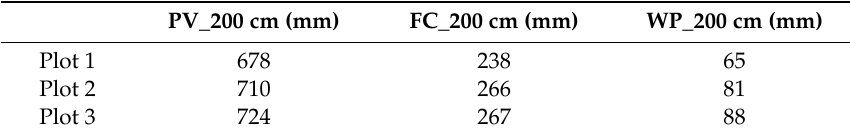
Table 3. Porosity for 200 cm soil depth (PV_200 cm, 0 hPa), field capacity (FC_200 cm, 100 hPa),